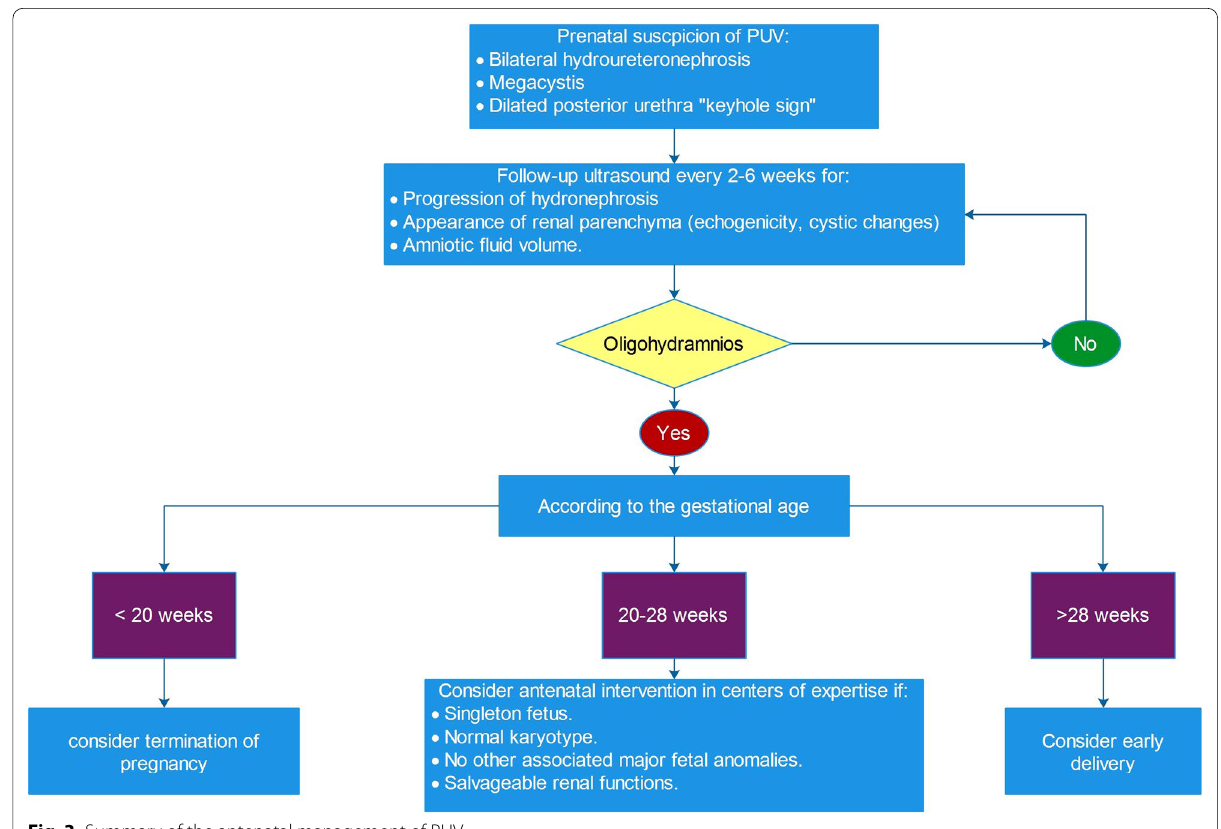
Fig. 3 Summary of the antenatal management of